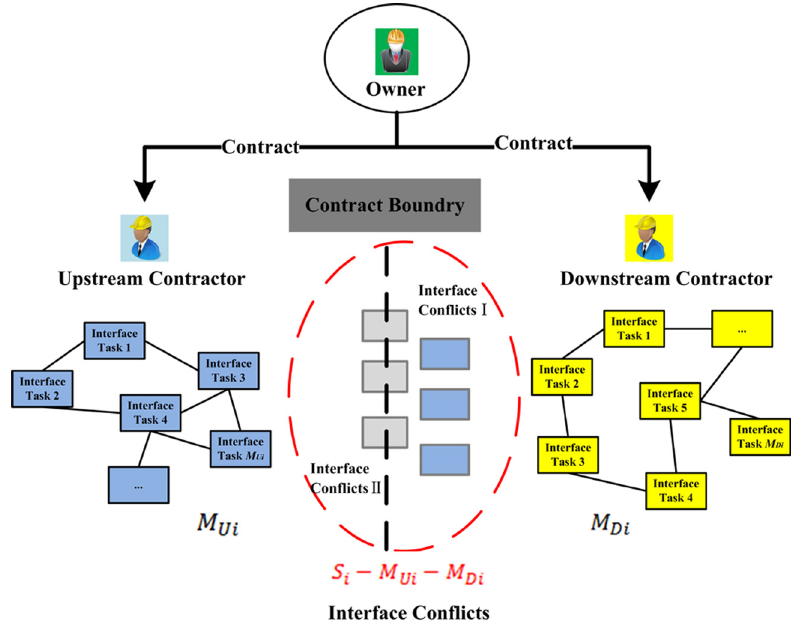
Fig. 3. Two types of interface